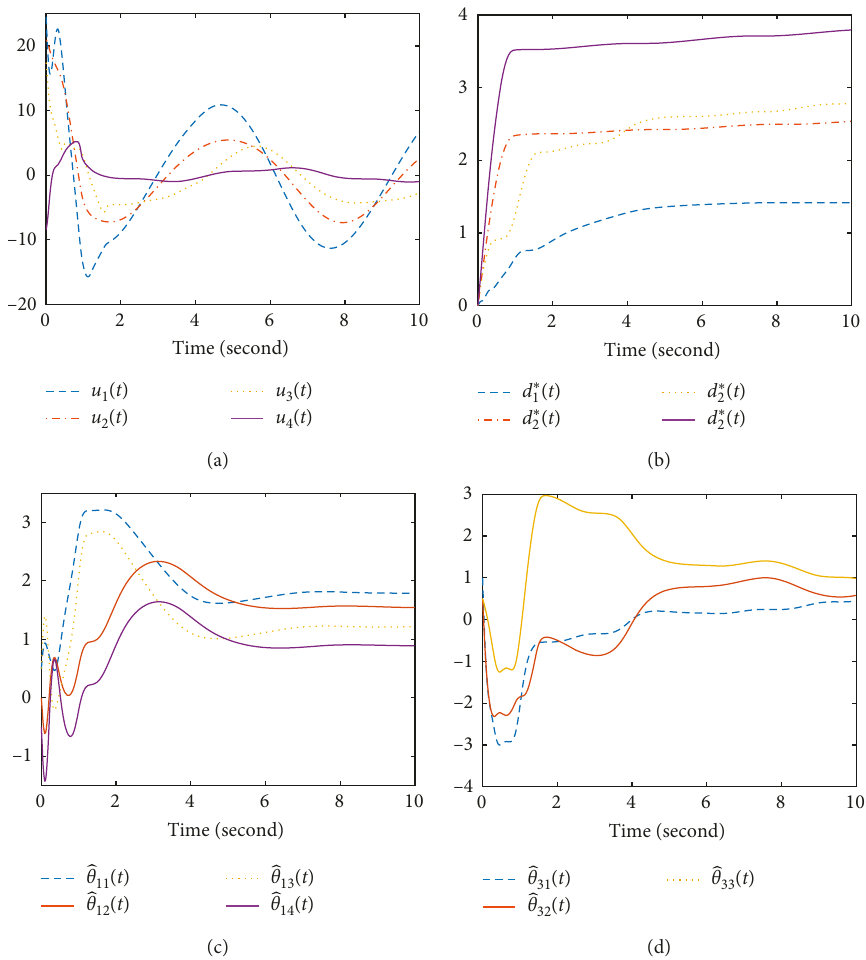
Figure 12: Control inputs and the updated